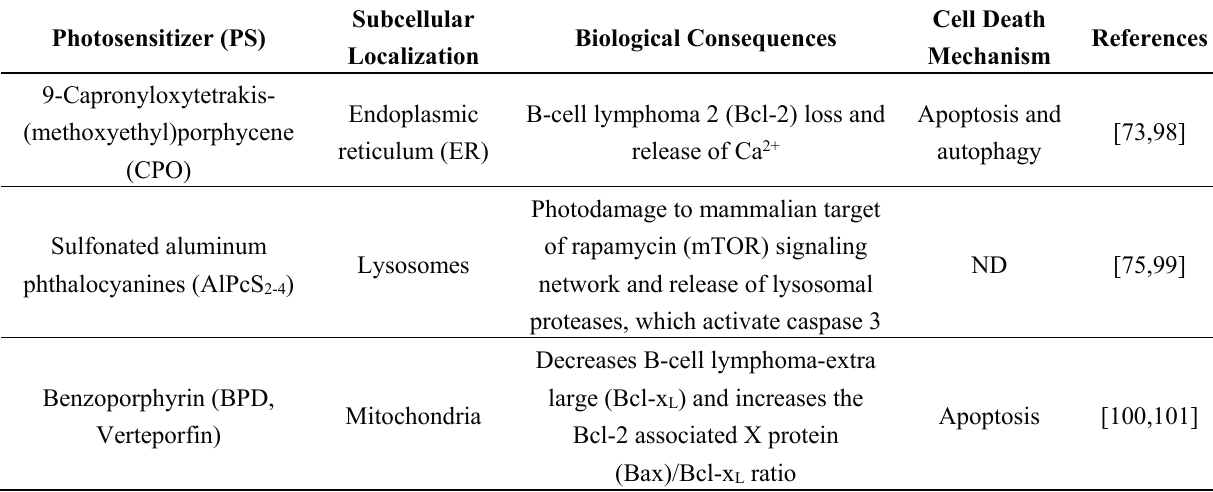
Figure 2. Biological outcomes of photodynamic therapy (PDT) associated with the amount of reactive species that are generated and possible targets of photooxidation. Note that it is not necessary to damage all targets together to trigger cell death. ( A ) High PDT-doses in organelles and photodamage of plasma membrane cause ATP depletion, resulting in non-programmed cell death (necrosis); ( B ) production of reactive species in mitochondria and/or damage to protein B-cell lymphoma 2 (Bcl-2) causes the release of cytochrome c and other apoptogenic factors, which classically trigger the caspases cascade, resulting in apoptosis. Photodamaging endoplasmic reticulum (ER) and lysosomes can also converge to mitochondrial damage, resulting in apoptosis; ( C ) low PDT-doses in organelles (mitochondria, ER and lysosomes) may activate autophagic process in an unbalanced manner (too much induction or flux inhibition), resulting in autophagic cell death. The inhibition of the mammalian target of rapamycin (mTOR) complex by photooxidation can also trigger autophagy as a cell death pathway. Table 1. Subcellular localization, biological consequences and cell death mechanisms induced by photosensitizers